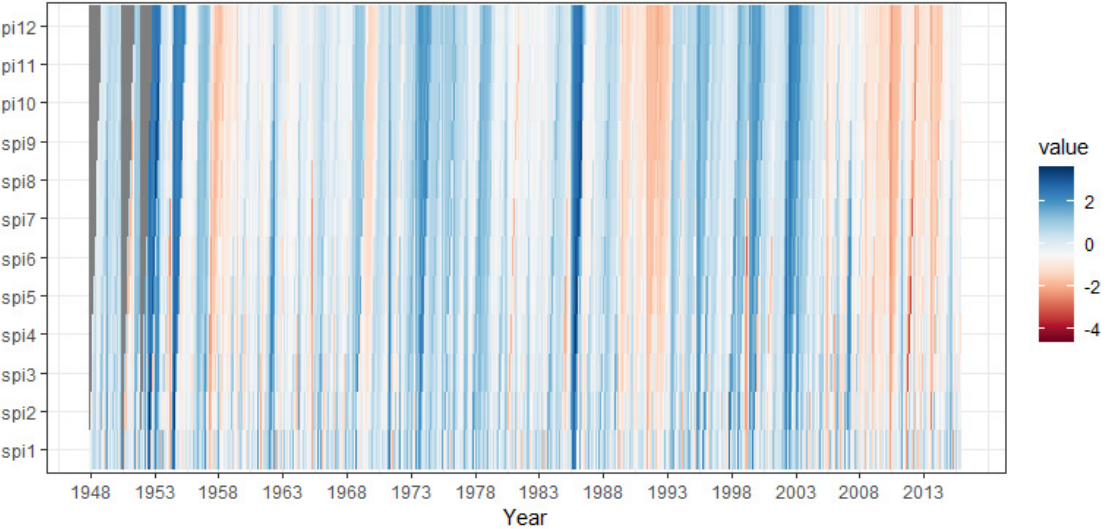
Figure 7. Drought heat map of Standard Precipitation Index SPI (SPI 1 to SPI 12) in the study